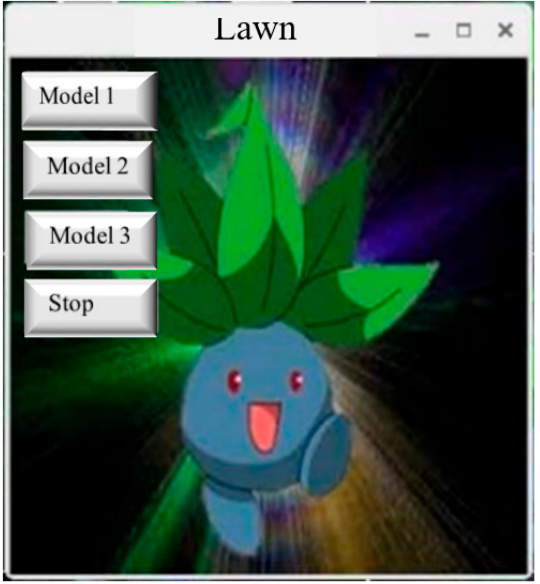
Figure 17. The human-machine interface displayed on the mobile phone.